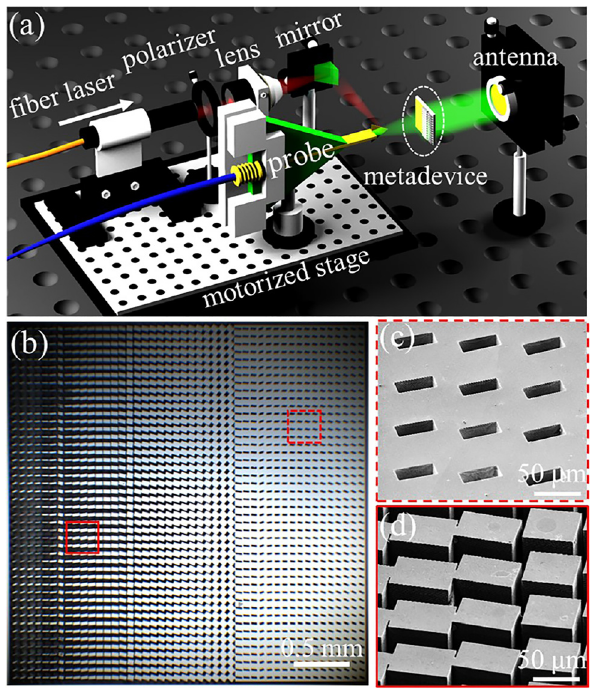
Figure 4: Experimental setup of the terahertz (THz) near-field scanning microscopy (NFSM) and sample